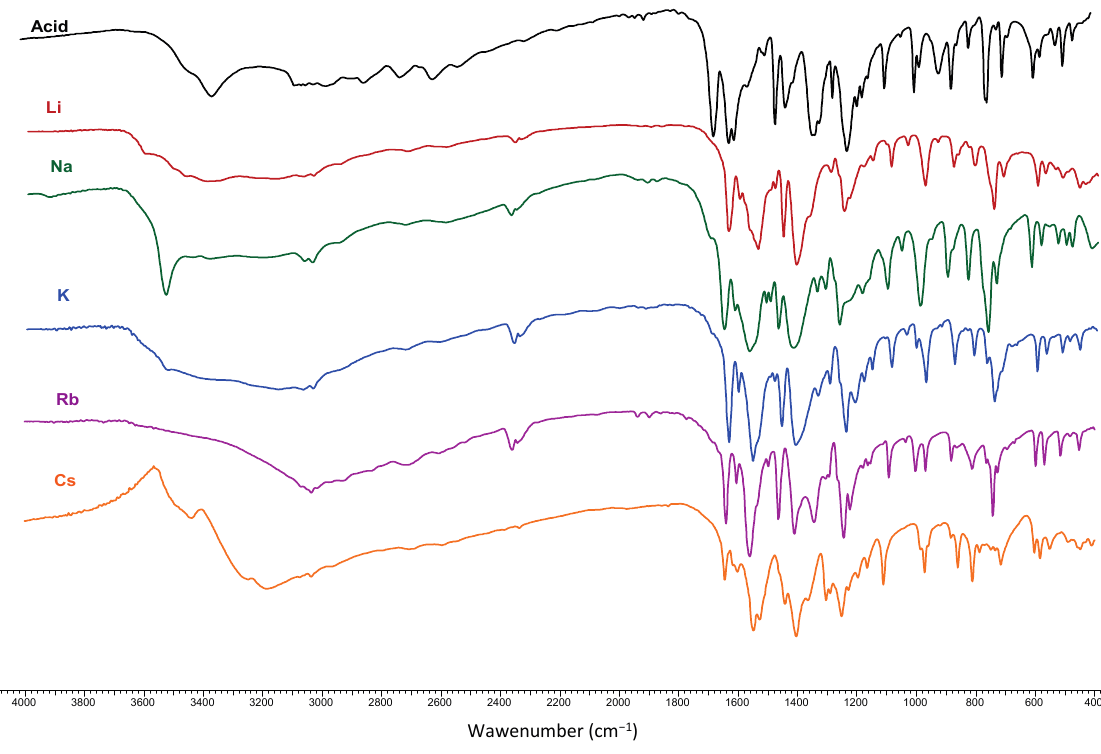
Figure 8. The IR spectra of trans o -coumaric acid and lithium, sodium, potassium, rubidium and cesium o -coumarates. Table 5. The wavenumbers (cm − 1 ) and assignments of bands occurring in the experimental FT-IR, FT-Raman and calculated spectra of trans o -coumaric acid. FT - IR FT - Raman Assignment No [26] Exp. Theoret. Int.